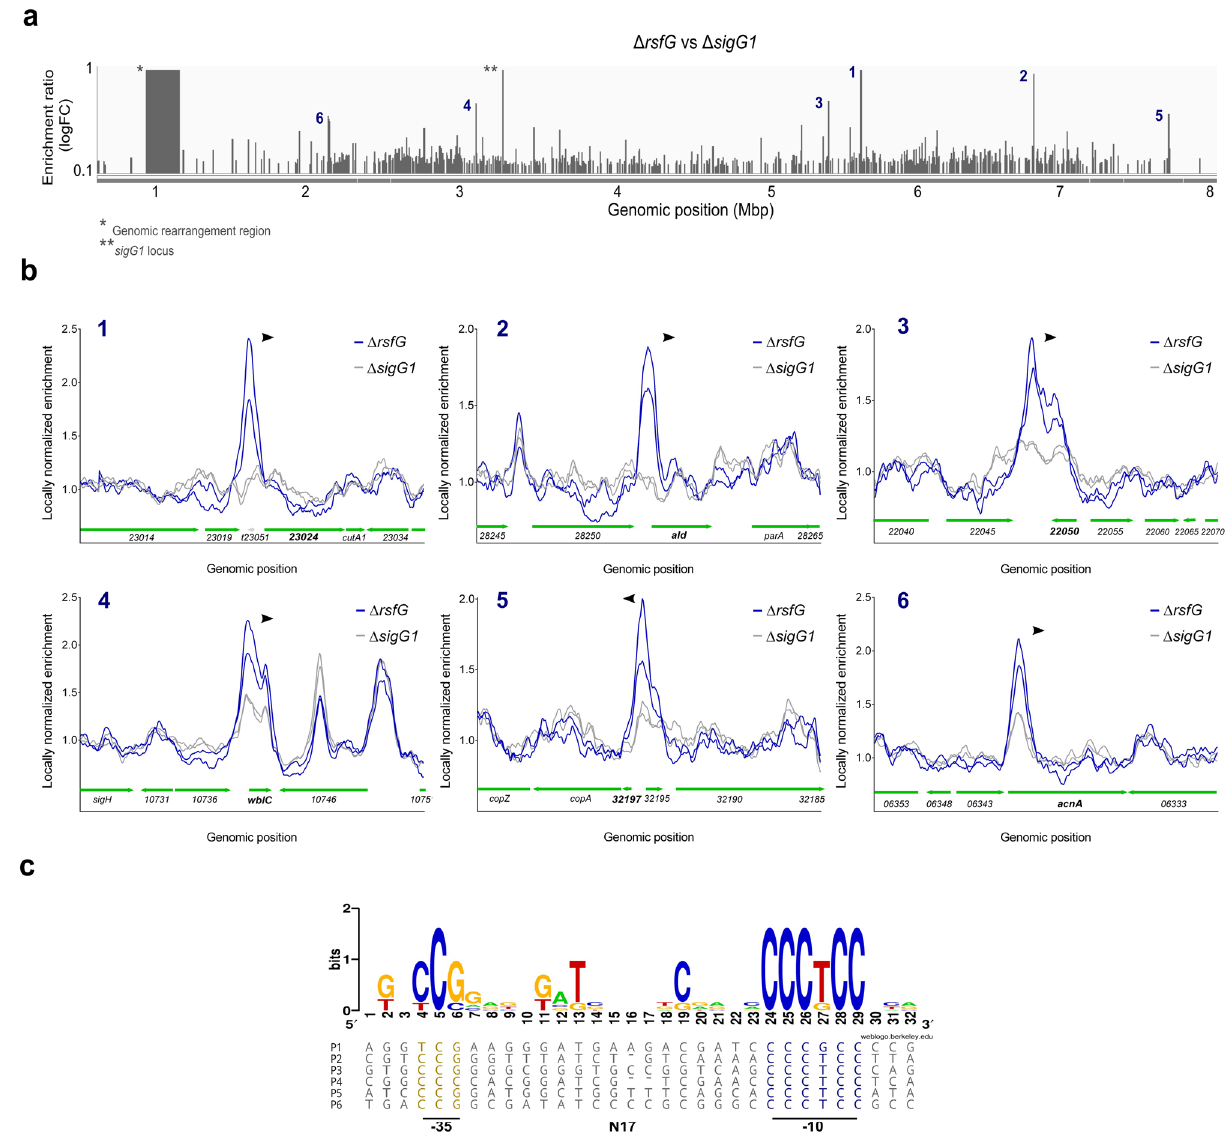
Figure 3. SigG1 binding to target promoters in vivo and in vitro ( a ) Genome-wide distribution of SigG1 binding sites identified by ChIP-seq analyses using the anti-SigG1 polyclonal antibody. Peak calling was performed from two independent biological replicates. ( b ) Close-up of a 2 kb region around the target genes. S. tsukubaensis Δ rsfG: blue. Negative control (Δ sigG1 ): grey. Genes in each genomic context are depicted in green ( c ) MEME consensus for SigG1 DNA-binding motif obtained by aligning the sigG1 -dependent ChIP- seq enriched sequences with the MUSCLE algorithm. The consensus logo was obtained using the WebLogo